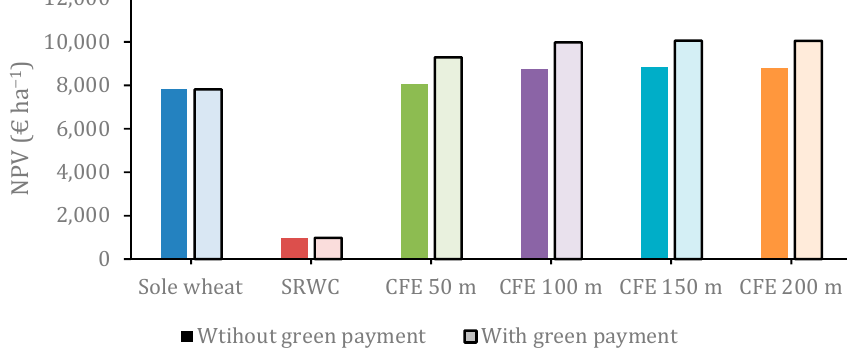
Figure 6. Net present value (NPV) with and without the green support payment.